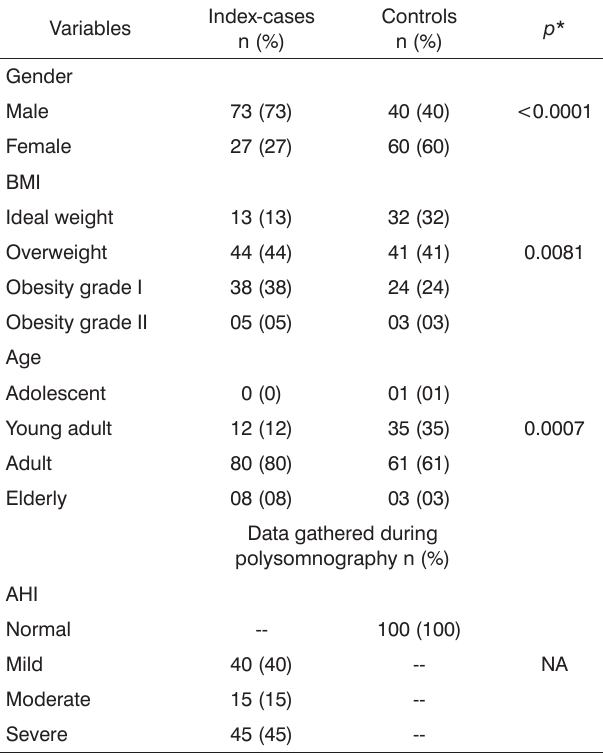
Table 1. Distribution of demographic data of index cases